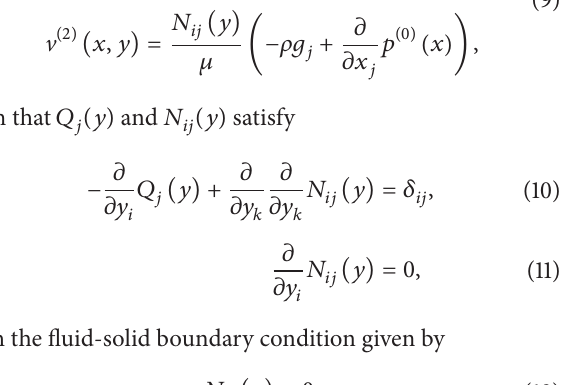
Figure 1: Macroscale (a) and microscale (b) domains used in the homogenizationproblem.Thesolidstructureinthe 𝑌 -cellillustrates the geometry of our first example: in-line array of solid shapes (i.e., circles or